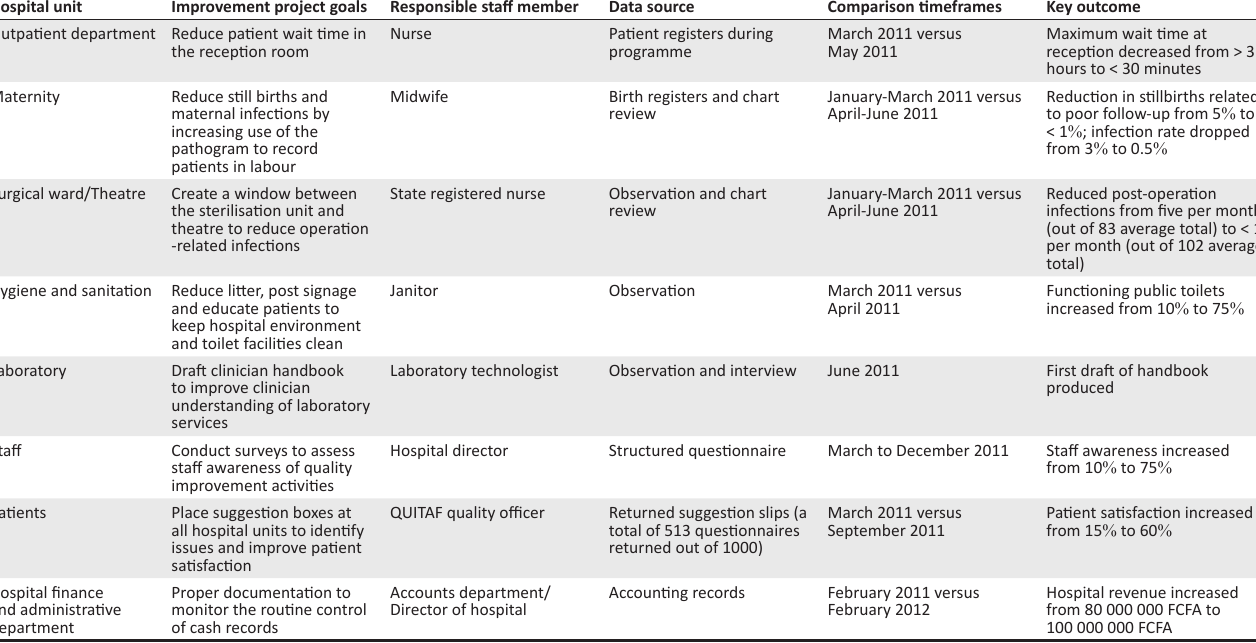
TABLE 2: Improvement projects at the Regional Hospital Buea selected by each unit head in collaboration with the entire Quality Improvement Task Force (QUITAF maternal) team from April 2011 to February